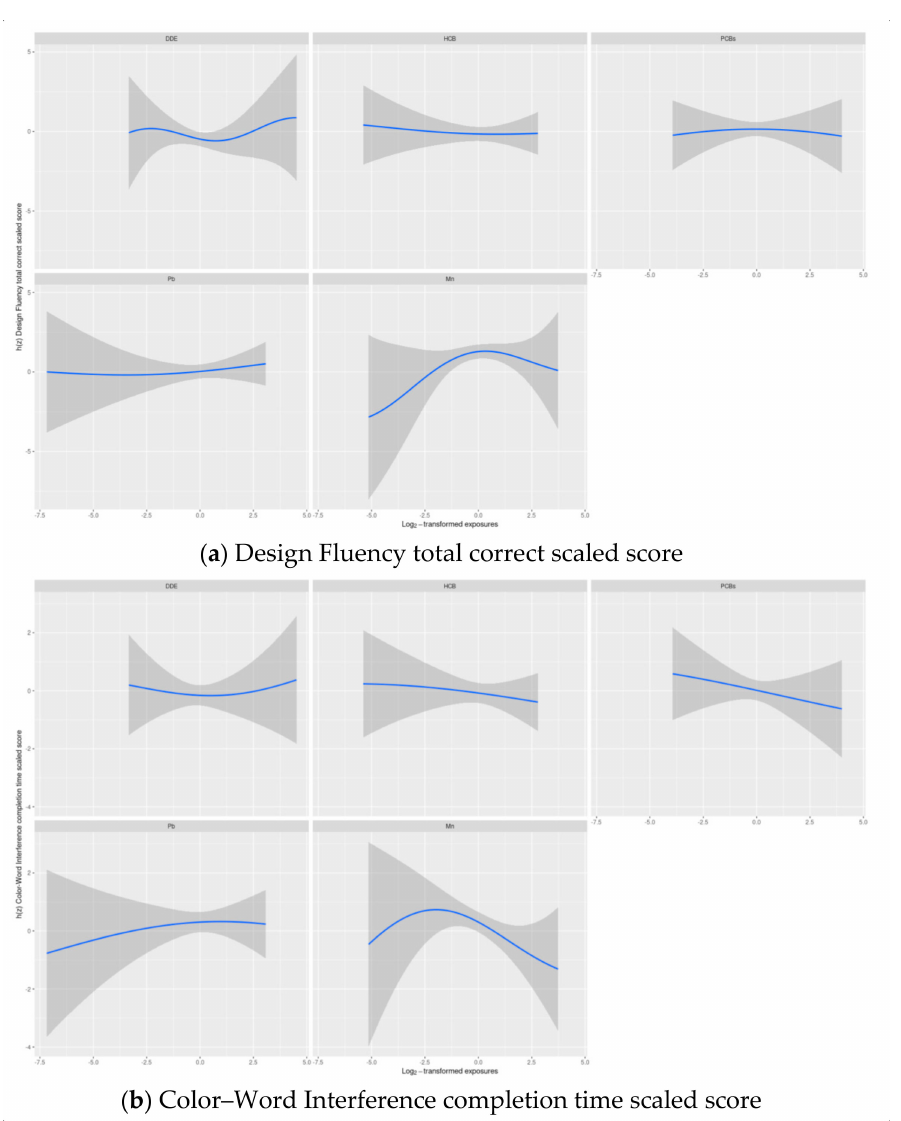
Figure 2. Estimated exposure-response functions and 95% credible intervals 1 of each of the five main exposures in Set 1 2 with the Delis–Kaplan Executive Function System inhibition scaled scores: ( a ) Design Fluency total correct scaled score and ( b ) Color–Word Interference completion time scaled score, where all remaining exposures are assigned to their median value among adolescents in the main analysis group. 1 Exposures have been log2-transformed and models have been adjusted for child race, sex, age at exam, year of birth and HOME score; maternal marital status at child’s birth, IQ, seafood consumption during pregnancy, and smoking during pregnancy; maternal and paternal education and annual household income at child’s birth; and study examiner. 2 Set 1: complete outcome, covariate and exposure data for DDE, HCB, Σ PCB 4 , Pb and Mn, n = 373. Abbreviations: DDE: dichlorodiphenyldichloroethylene; HCB: hexachlorobenzene; Σ PCB 4 : Sum of 4 PCB congeners (118, 138, 153, 180); Pb: lead; Mn: